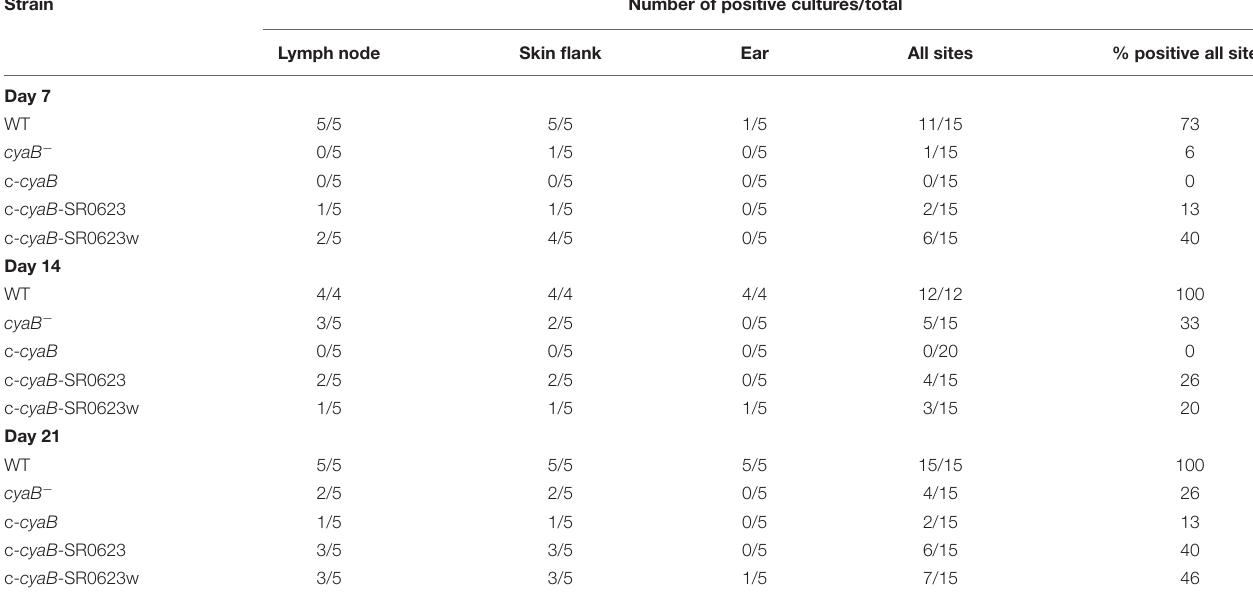
TABLE 2 | Tissue infectivity of B. burgdorferi -infected mice. Strain Number of positive cultures/total Lymph node Skin flank Ear All